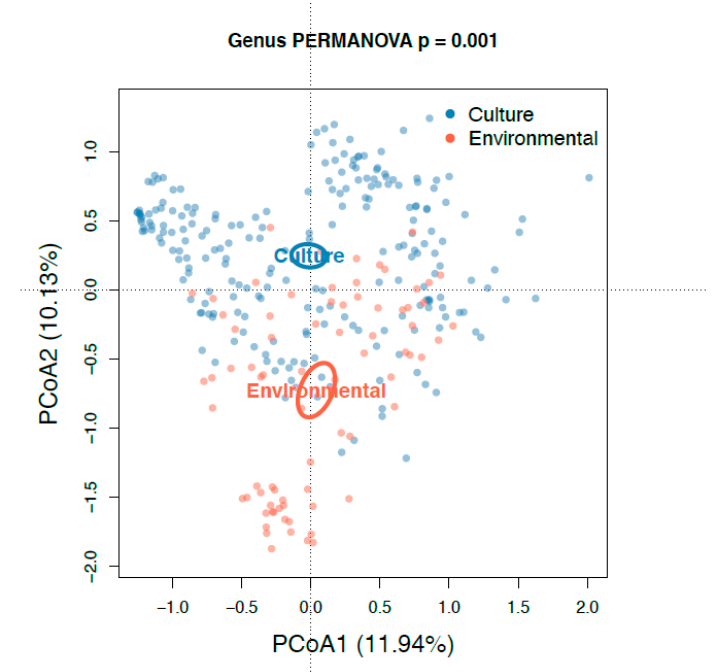
Figure 7. Bray Curtis PCoA ordination for all culture-independent and culture-dependent samples. Beta diversities at the genus level from 16S rRNA gene sequencing are shown with PC1 and PC2 components. Data are clustered and colored by the two sequencing approaches utilized.